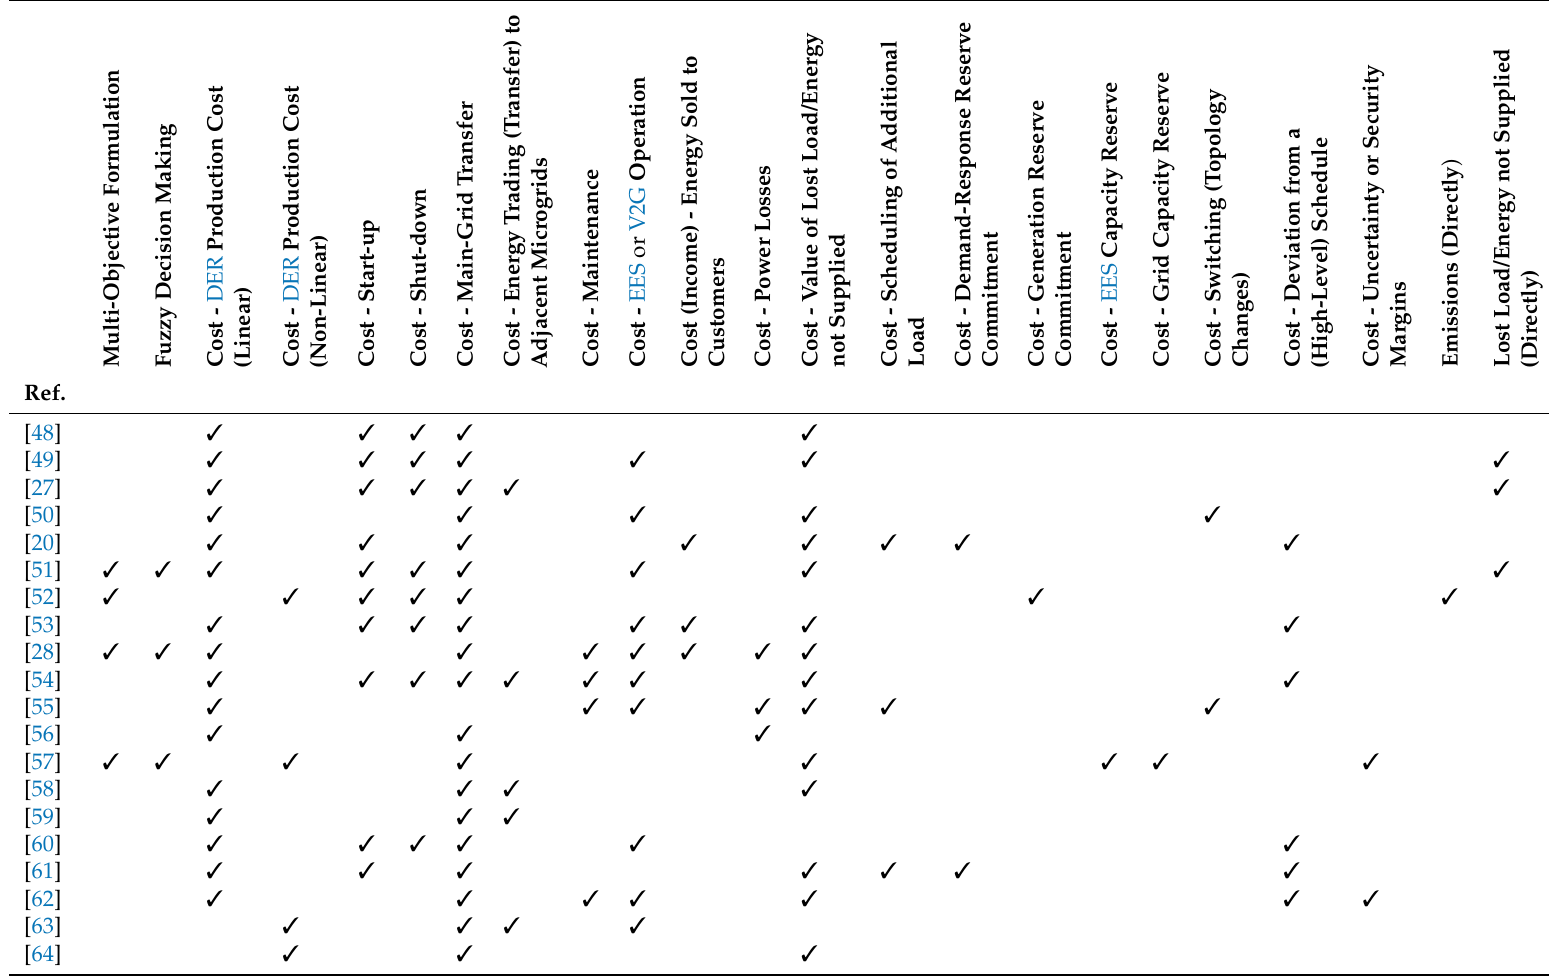
Table 6. Objective terms ( (cid:51) :